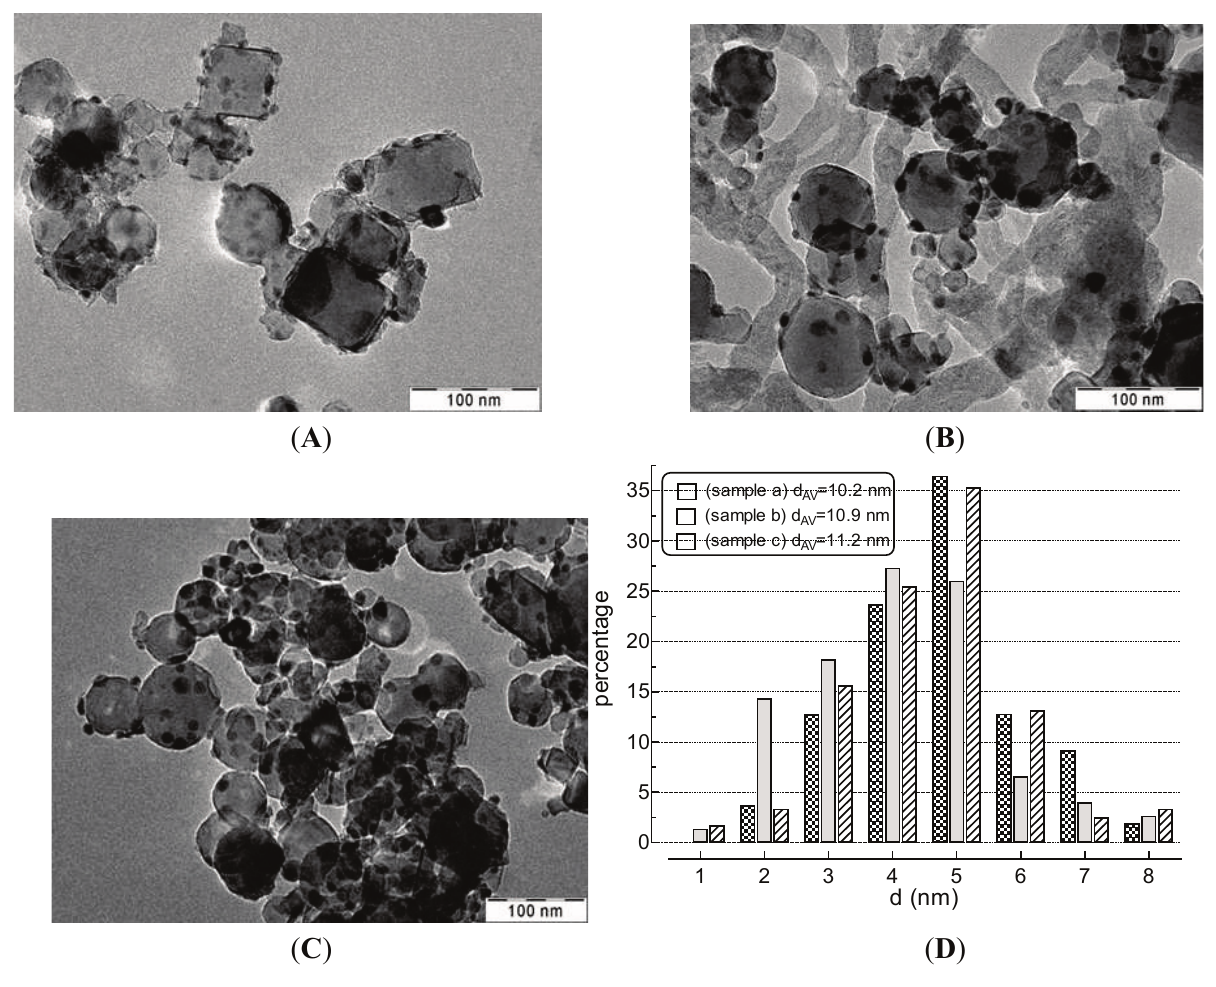
Figure 4. TEM views ( A – C ) and PSD ( D ) of the “fresh” and “used” catalyst samples: ( A ) “fresh”; ( B ) “used” (run b); ( C ) “used” (run e); ( D ) CSD’s of samples reproduced in panels